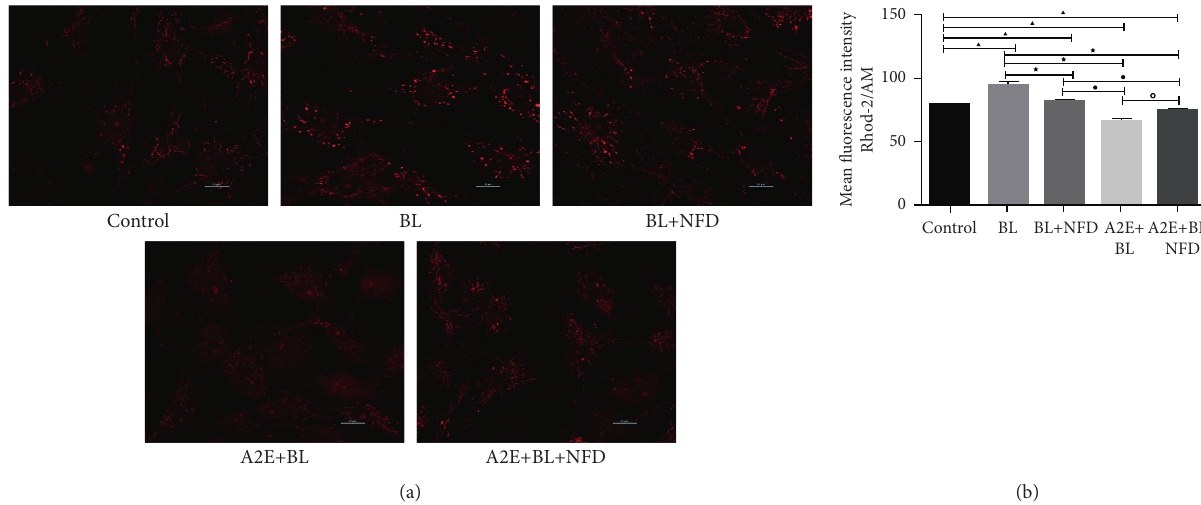
Figure 3: The calcium level in mitochondria. (a) For the determination of Ca 2+ levels in mitochondria, the fluorescence intensity of calcium in RPE cells was assessed by confocal microscopy using the calcium-sensitive dye Rhod-2/AM. Scale bar � 20 μ M. (b) Data are presented as the mean ± SD ( n � 3). An LSD test following one-way ANOVA was performed for the statistical analysis. ▲ P < 0 . 05, compared with the controls; ★ P < 0 . 05, compared with the BL group; ● P < 0 . 0505, compared with the BL+NFD group; and ◇ P < 0 . 05, compared with the A2E